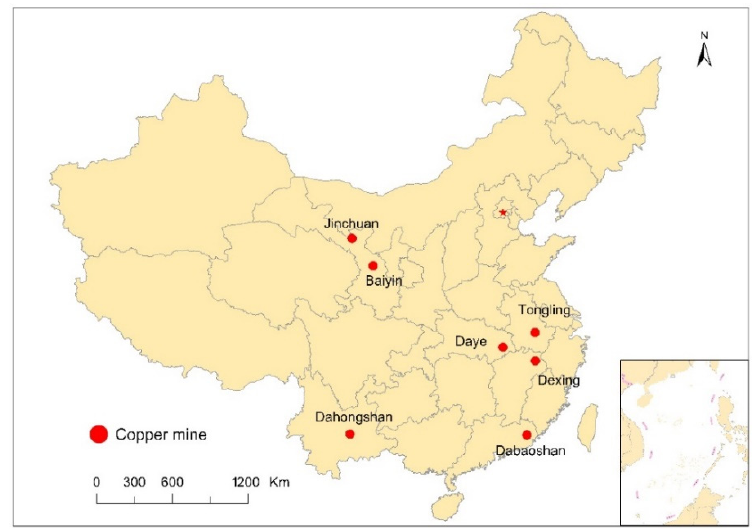
Figure 1. Location of seven representative copper mines in China. Table 1. Analysis methods of heavy metal elements used in seven